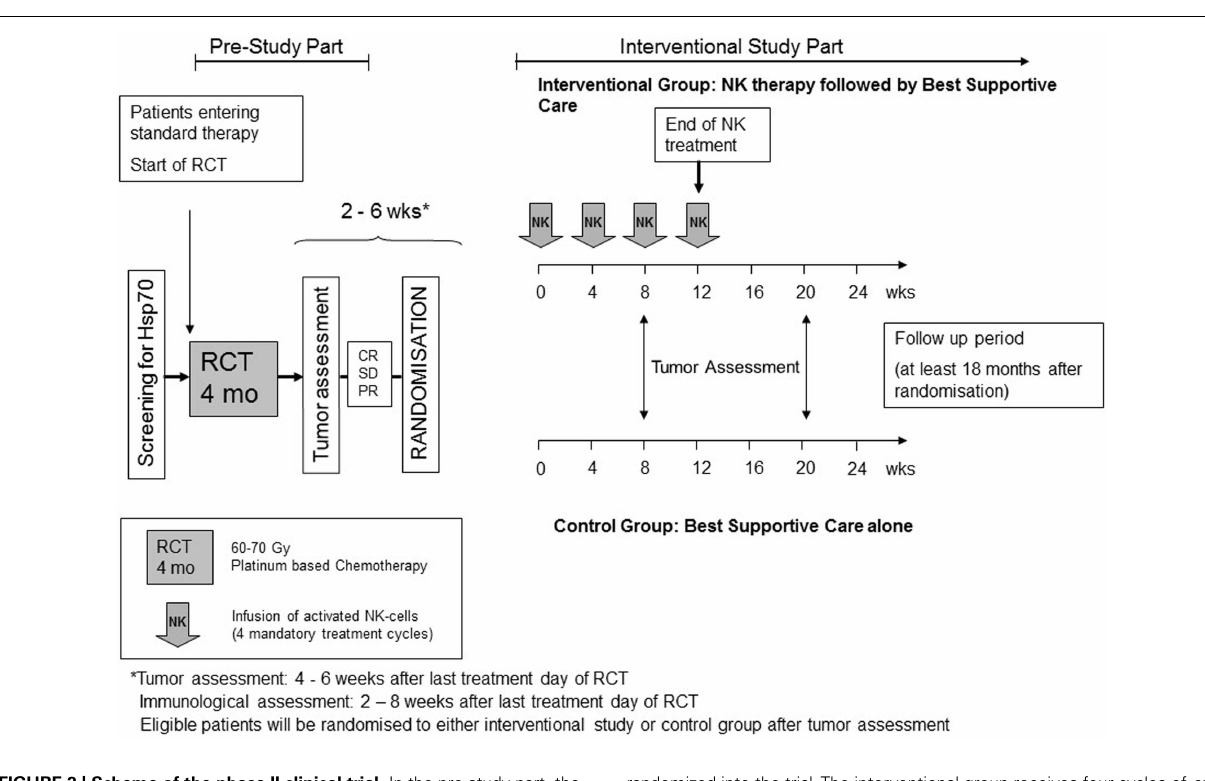
FIGURE 2 | Scheme of the phase II clinical trial . In the pre-study part, the Hsp70 phenotype and the stage of the tumor disease is assessed. Only Hsp70-positive NSCLC patients in stage IIIA/B who received a radiochemotherapy (RCTx) and showed at least a stable disease are